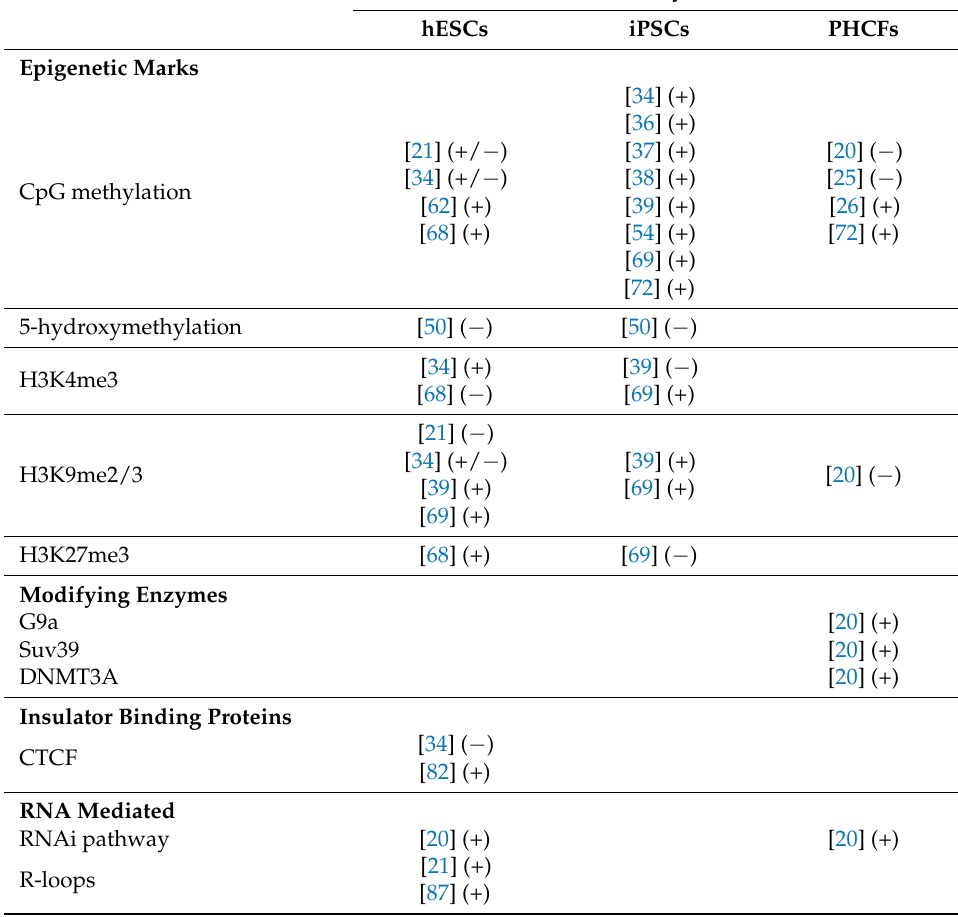
Table 1. Evidence for the presence (+)/absence ( − ) of factors that may be involved in FMR1 epigenetic silencing in various pluripotent stem cell (PSC)-based models of